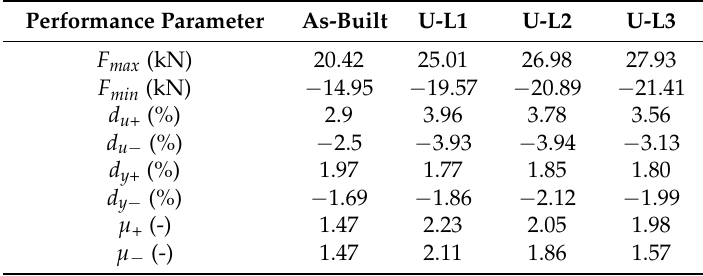
Table 4. Comparison of main results from FE analysis of CFRP and as-built joints.